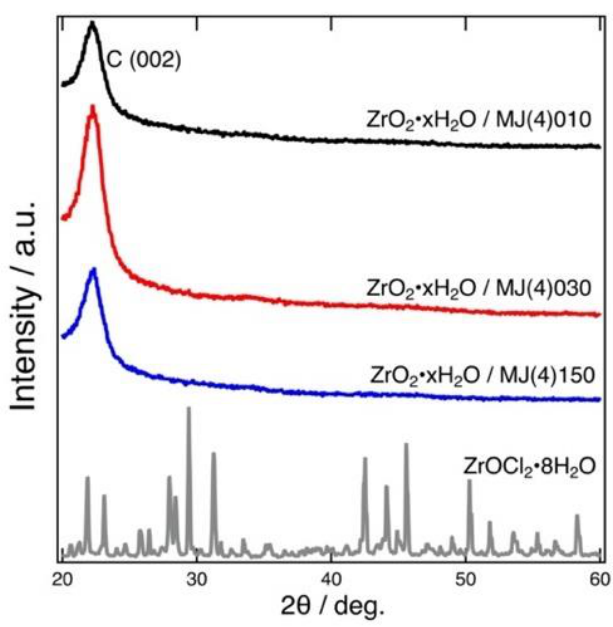
Figure 2. Powder XRD patterns of the prepared adsorbents: ZrO 2 ·xH 2 O/MJ(4)010 ( black ),